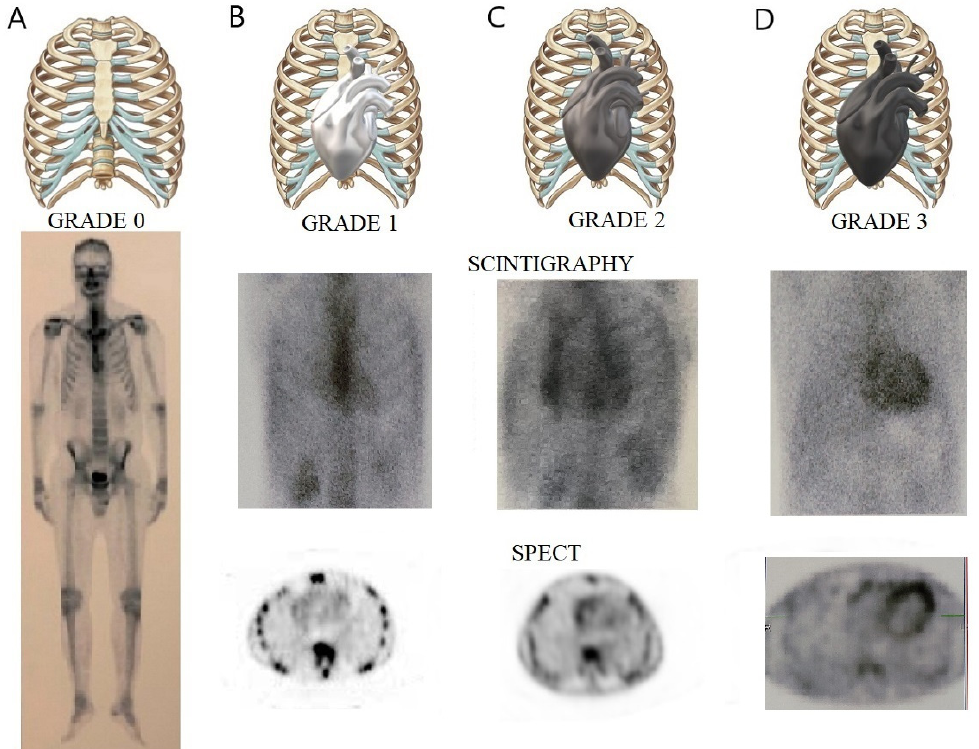
Figure 6. Cardiac scintigraphy with 99m Tc-PYP in ATTR cardiac amyloidosis . Upper panel illustrating with 3D chest impression Perugini grading scale of myocardial uptake. Lower panel illustrating the presence of a heart silhouette on chest planar imaging (middle row), and the radionuclide distribution at the level of the myocardial walls on SPECT imaging (bottom row) in varying degrees, from left to right. ( A ) Perugini score 0—no cardiac uptake. ( B ) Perugini score 1—low cardiac uptake below the bone uptake. ( C ) Perugini score 2—moderate cardiac uptake similar to the bone tissue. ( D ) Perugini score 3—high cardiac uptake greater than rib uptake, with biventricular involvement.